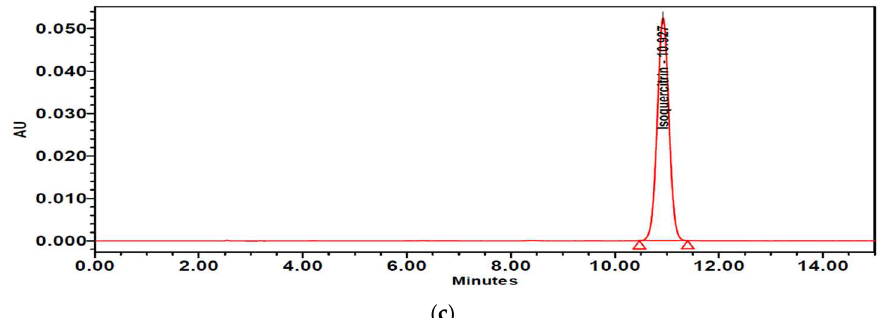
Figure 9. High-performance liquid chromatography (HPLC) chromatograms of ( a ) PTFE and ( b ) PTFFE. ( c ) Peak of the isoquercitrin standard.